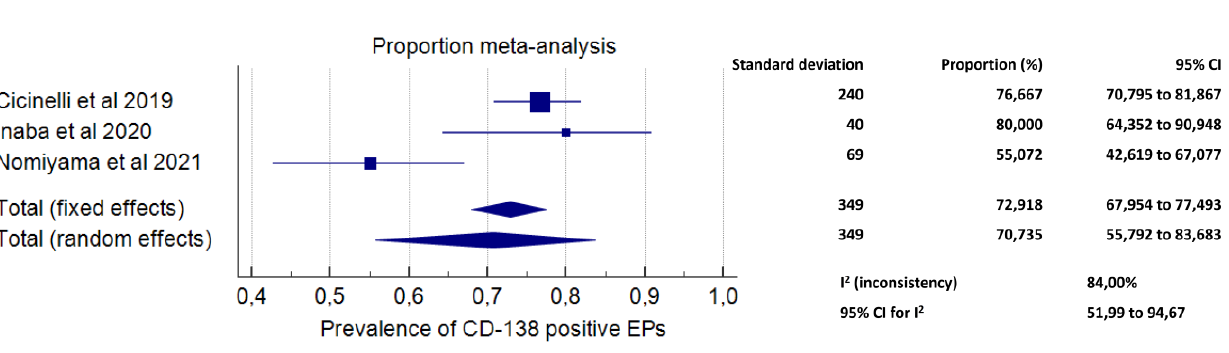
Figure 3. Forest plot. Proportion of CD-138 immunoreactive endometrial polyps.